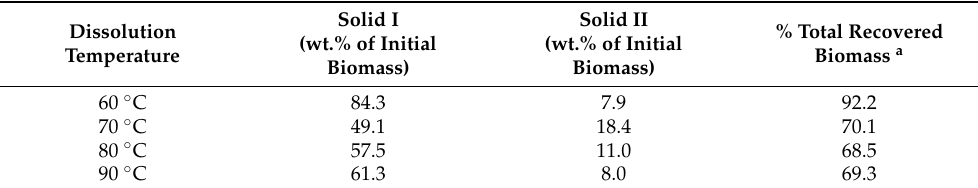
Table 2. Mass balance results of pruning waste after treatment with ISH between 60 and 90 ◦ C after 24 h of reaction (solids dried at 105 ◦